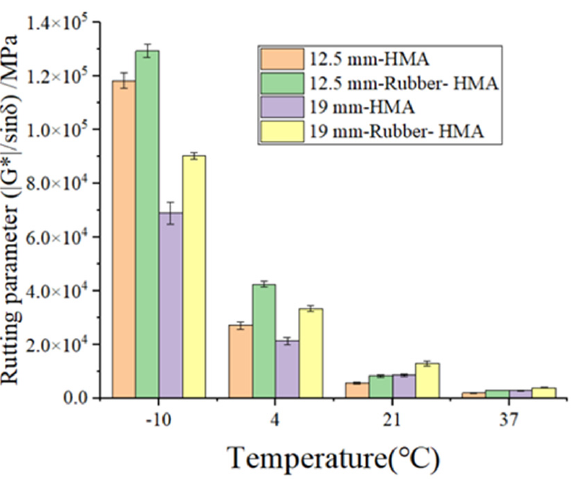
Figure 9. Rutting parameter (|G*|/sin δ ) at 10 Hz of various types of HMA.